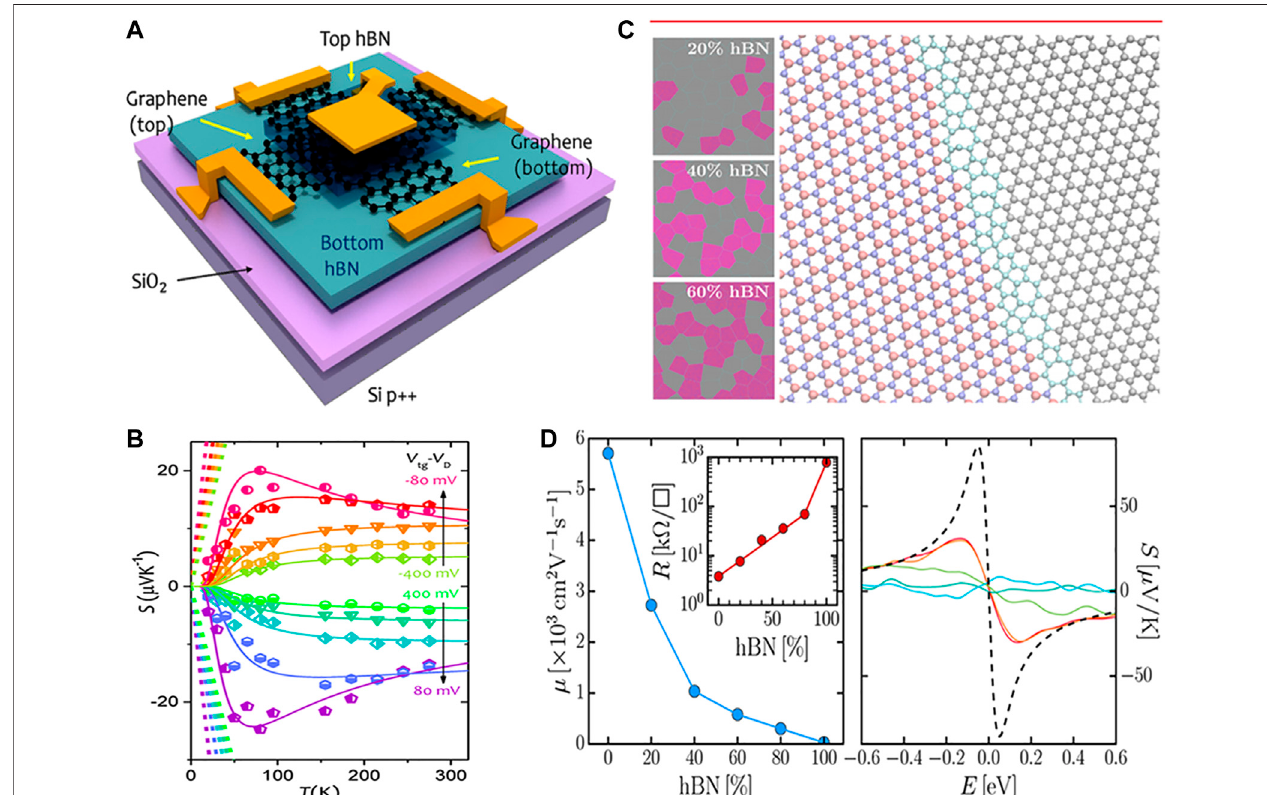
FIGURE 11 | (A) Schematic of the h-BN-encapsulated twisted-bilayer graphene device geometry including the contact pads used for the cross-plane thermoelectricity measurement. (B) Temperature dependence of the Seebeck coef fi cient for different calculated from the Landauer − Buttiker formalism. Reproduced from (Barrios-Vargas et al., 2017) with permission from the American Chemical Society. (C) Square periodic polycrystalline structures with three different concentrations of h-BN and magni fi cation of the polycrystalline structure showing a typical interface between grapheneandh-BNgrains. (D) Mobilityasafunctionofh-BNconcentrationfora fi xedcarrierdensityandSeebeckcoef fi cientwithincreasingh-BNgraindensity,withthe dashed line showing the pristine graphene value. Reproduced from (Mahapatra et al., 2017) with permission from the American Chemical Society.